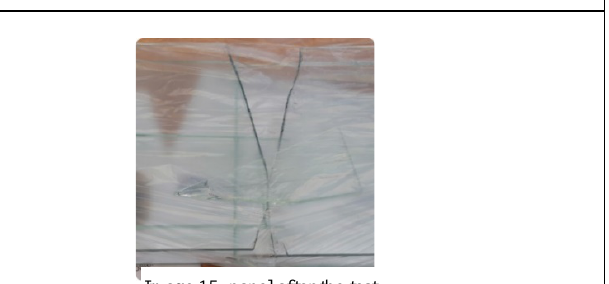
Image 15: panel after the test